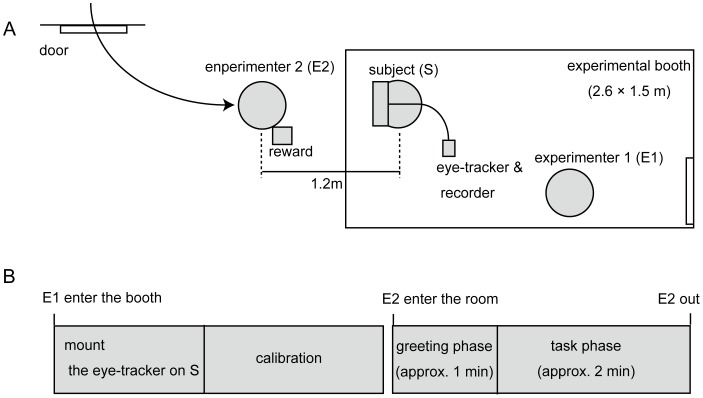
Experimental procedures.(A) Schematic of the experimental setting. (B) Time flow of an experimental session.